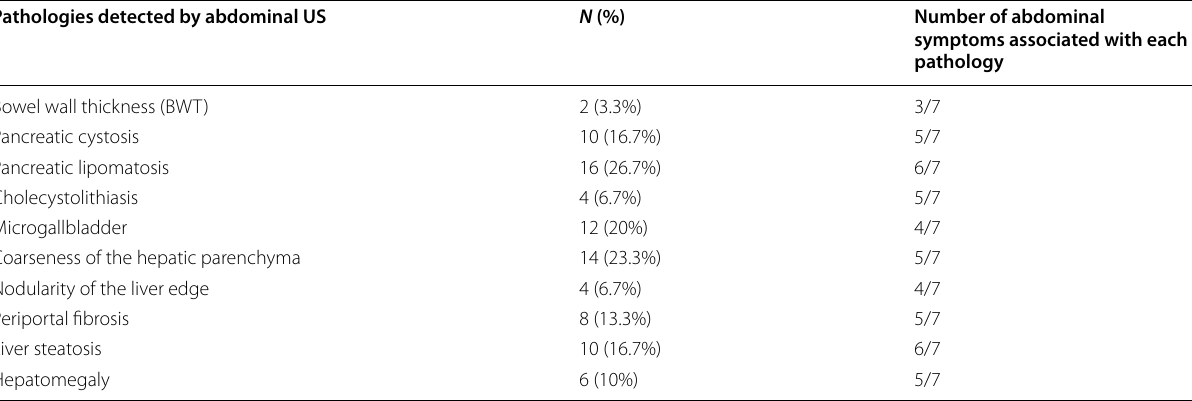
Table 4 Frequencies (score) of detected abnormalities in abdominal ultrasound and associated abdominal symptoms Pathologies detected by abdominal US N (%) Number of abdominal